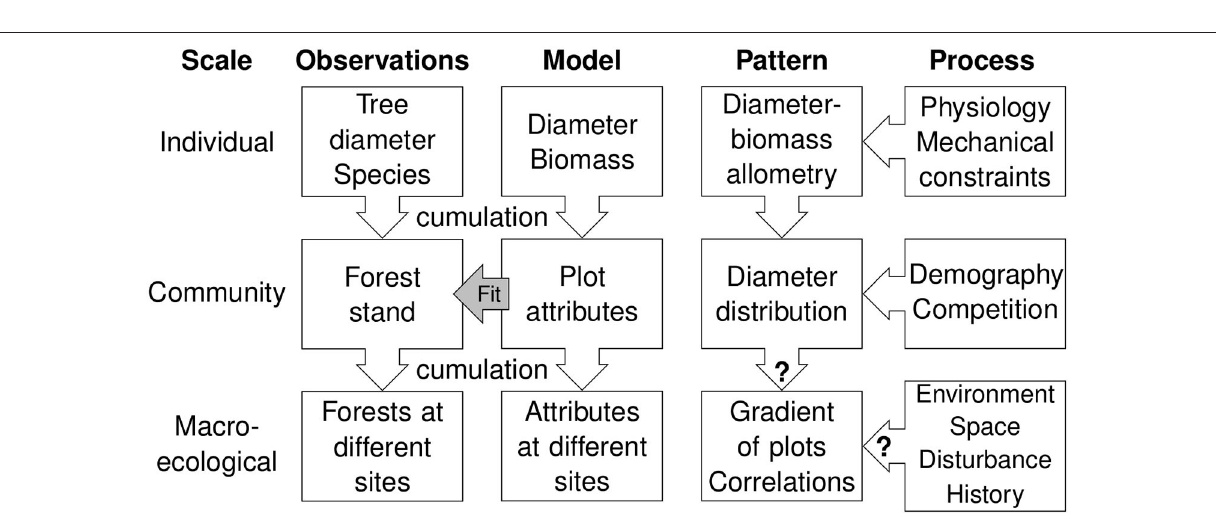
FIGURE 5 | predictions of the exponential model (E,F) . (A,C,E) Correlation circle between the first two axes of the PCA and the chord-transformed abundances in the dbh classes (from 10 to 20 cm for the first dbh class to ≥ 110 cm for the 11th dbh class). The insets show the eigenvalues of the PCA. (B,D,F) Projection of the forest plots on the first two axes of the PCA. Each dot corresponds to a plot with the color indicating the site. Lines and ellipses highlight the dispersion of the plots of each site.